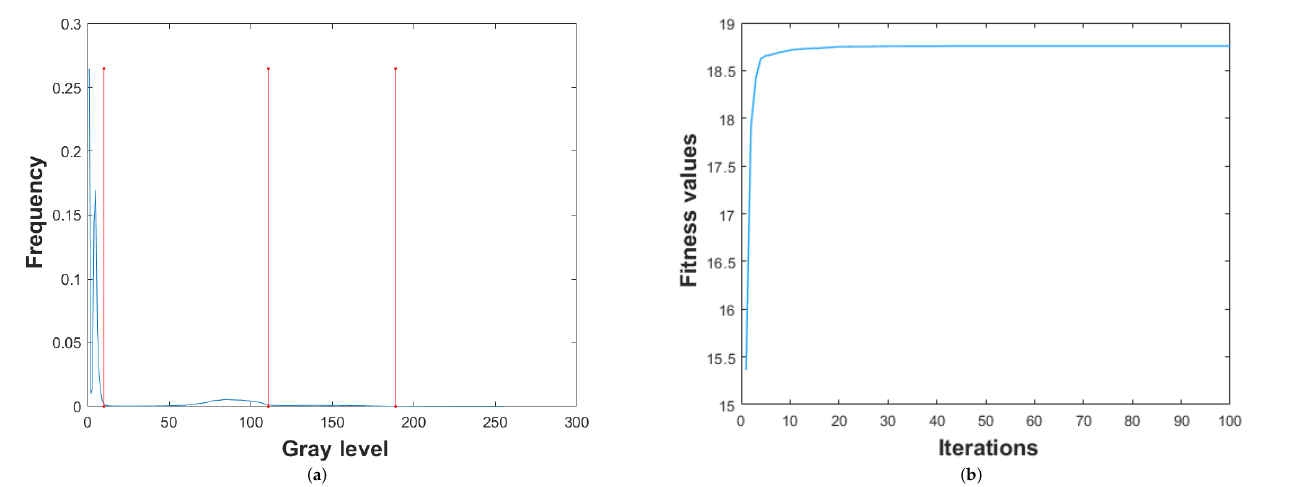
Figure 7. Multilevel threshold and convergence curve of proposed hybrid segmentation approach. ( a ) Multilevel thresholds and ( b ) Convergence